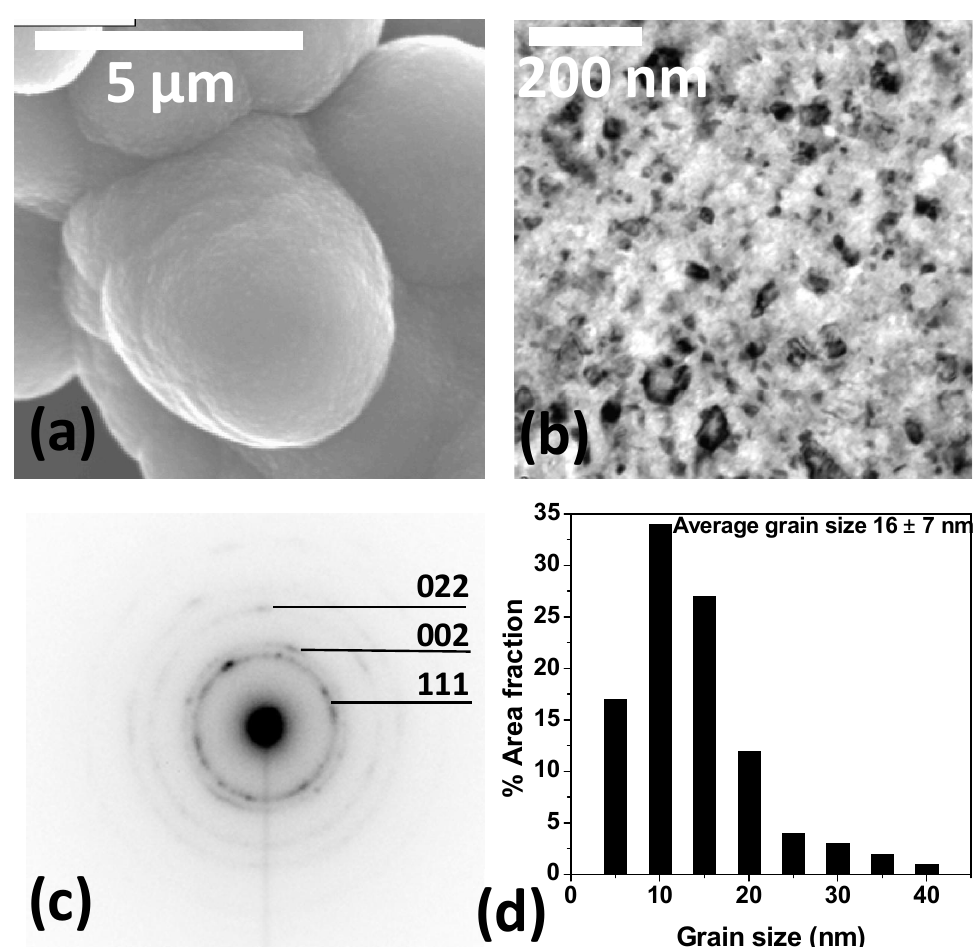
Figure 5. ( a ) SEM image of smooth globular morphology; ( b ) Bright Field TEM image of smooth globular morphology; ( c ) selected area electron diffraction pattern indicating presence of fcc–Al(Mg) phase; ( d ) grain size